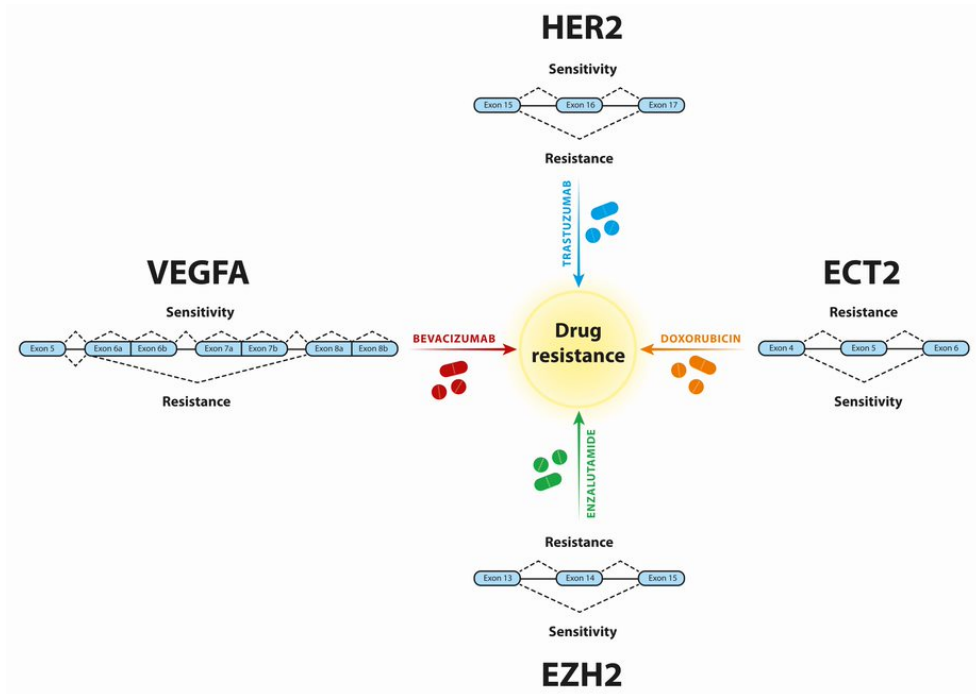
Figure 2. Examples of AS events leading to cancer drug resistance. The AS of HER2, ECT2, EZH2, and VEGFA conferring resistance or sensitivity, respectively, to Trastuzumab, Doxorubicin, Enzalutamide, and Bevacizumab is shown.